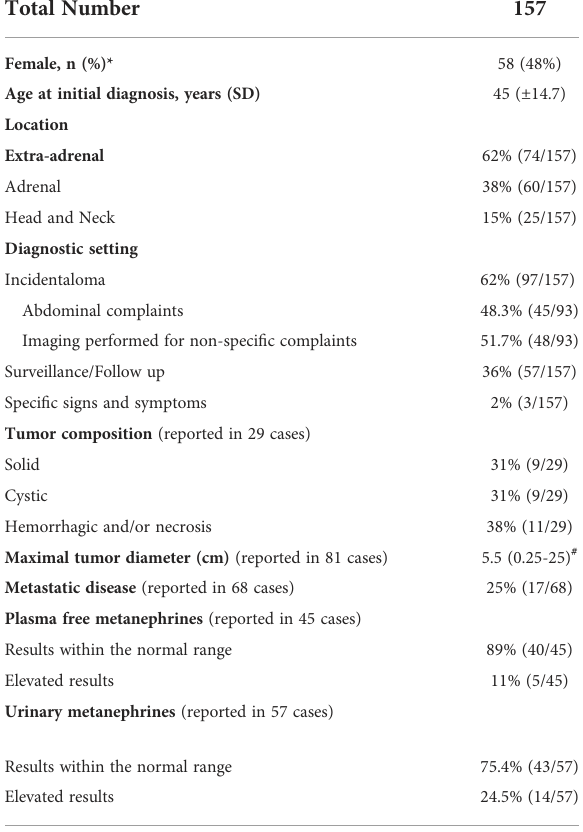
TABLE 1 Patient